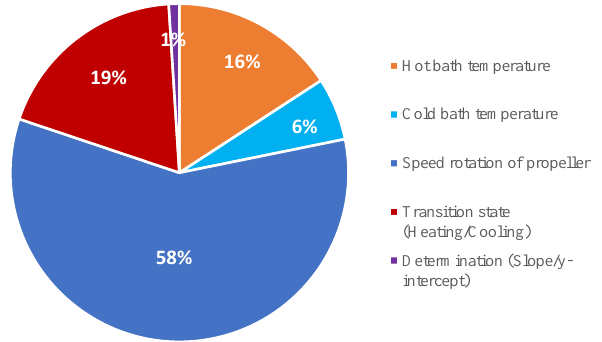
Fig. 9 Quantification of the influence of each